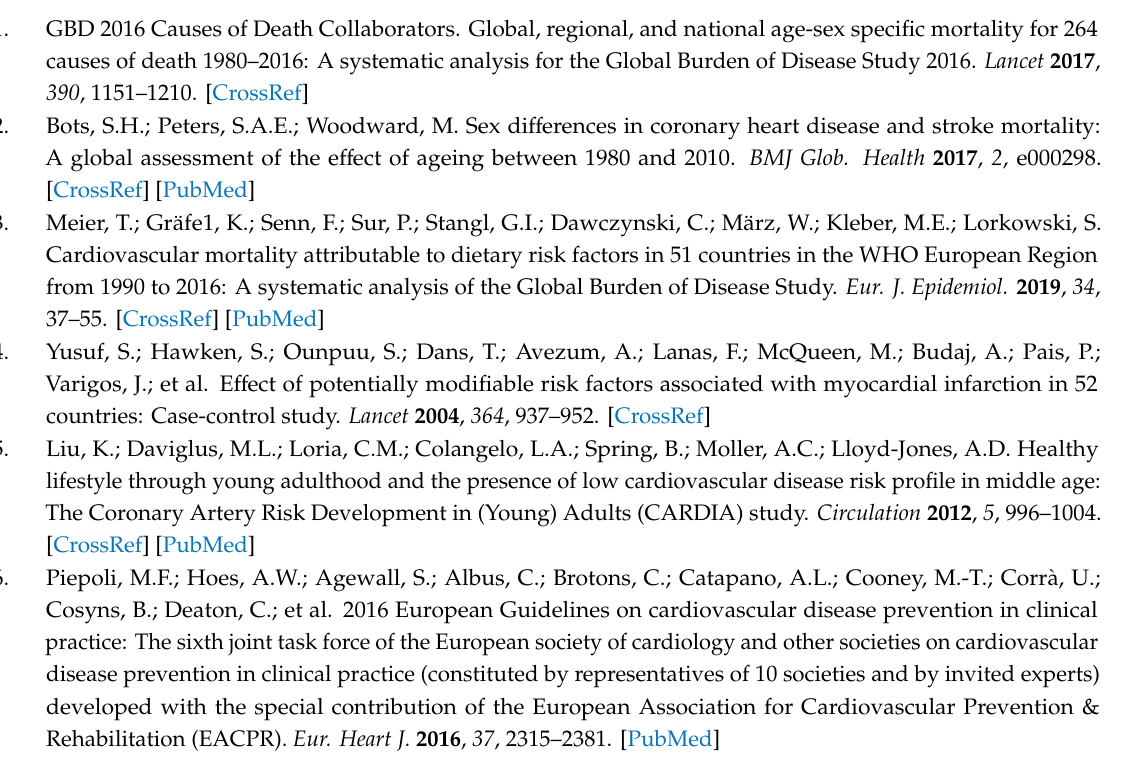
Table S1: Unadjusted odds ratios and 95% confidence intervals for cardiovascular diseases in men and